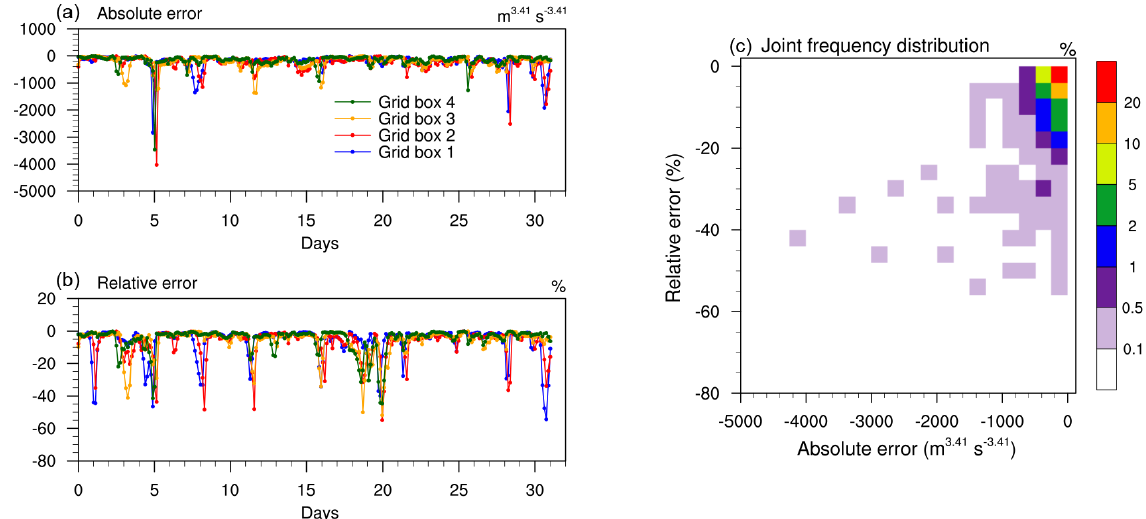
Figure 4. (a–b) Time series of the error of U 3 . 41 in the four 225km × 225km grid boxes in the WRF domain over the Southern Ocean 10 (cf. Fig. 1 and Sect. 3). The absolute and relative errors are calculated for Eq. (10) assuming Eq. (11) is the “truth”. (c) Joint frequency distribution of the relative and absolute errors. All the four time series shown in panels (a) and (b) are considered as one sample for the